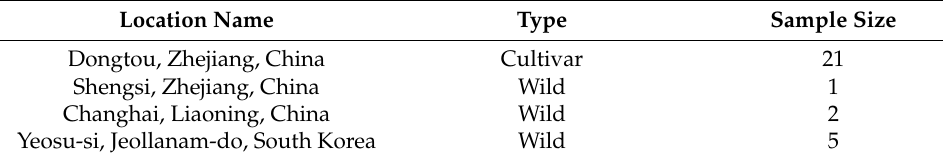
Table 1. Sample information of collected S. fusiforme for